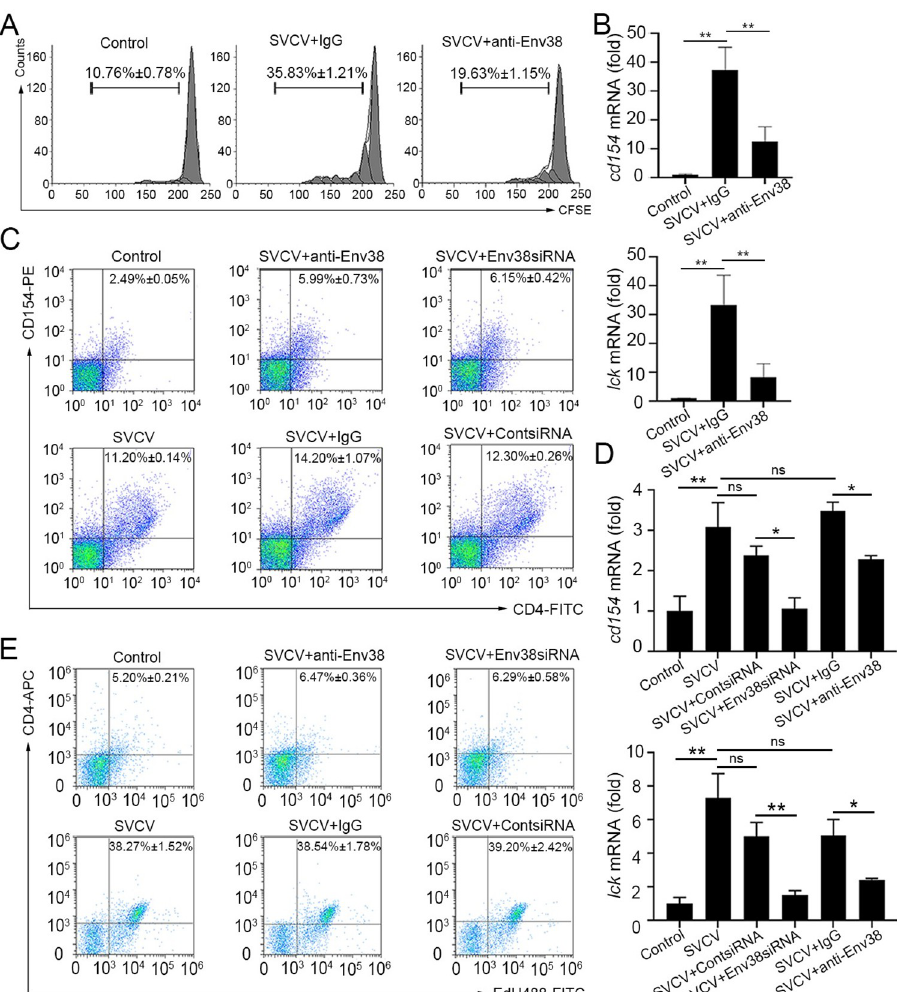
Fig 7. Evaluation on the functional role of Env38 in APC-initiated Ag-specific CD4 + T cell activation. (A and B) In vitro examination on the proliferation (A) and activation (B) of CD4 + T SVCV cells isolated from zebrafish stimulated with inactivated SVCV (10 6 TCID 50 ) and impaired by blockade of Env38 on APCs with anti-Env38 Ab (5 μ g/ml) as determined by the CFSE dilution through FCM analysis and the transcriptional expression of cd154 and lck genes through RT-qPCR. (C and D) In vivo examination on the activation of CD4 + T cells stimulated with SVCV (10 5 TCID 50 ) and impaired by blockade or knockdown of Env38 with i.p administering anti-Env38 Ab (10 μ g/fish) or Env38siRNA-LV (1 × 10 6 TU/fish) as determined by the percentage of CD4 + CD154 + T cells with mouse anti-CD154 (1:500) and rabbit anti-CD4 (1:500) in leukocytes from spleen, head kidney and peripheral blood through FCM analysis (C) and the transcriptional expression of cd154 and lck genes through RT-qPCR (D). (E) In vivo examination on the proliferation of CD4 + T cells of zebrafish stimulated with SVCV (10 5 TCID 50 ) and impaired by blockade or knockdown of Env38 with i.p administering anti-Env38 Ab (10 μ g/fish) or Env38siRNA-LV (1 × 10 6 TU/fish) as determined by the percentage of CD4 + EdU + T cells with rabbit anti-CD4 (1:500) in leukocytes from spleen, head kidney and peripheral blood as determined by FCM analysis. Nonrelated control groups were administered with isotype IgG or scrambled siRNA-LV. Negative control groups received mock PBS. The data presented in each block diagram indicated the average percentage of CD4 + CD154 + T cells or CD4 + EdU + T cells in each treatment group. RT- qPCRs were run in combination with the endogenous β -actin control. Error bars represented SEM. ( � p < 0.05; �� p < 0.01; ��� p < 0.001; ns, no significant difference).